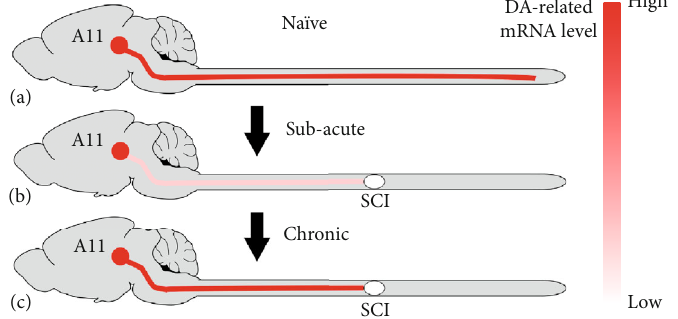
Figure 7: A diagram illustrating the dynamic changes of DA-related mRNA levels in A11 diencephalospinal pathways after SCI. Diencephalic A11 neurons project to all levels of the spinal cord. The majority of DA-related transcripts are transiently reduced in the spinal cord rostral to the injury site, while they are consistently decreased in the caudal spinal cord. In the chronic phase, remaining A11 diencephalospinal pathways undergo restoration of DA-related transcripts in the rostral spinal cord. Notably, the number of A11 DA-ergic neurons and DA- related mRNA levels in the neuroplasm do not change after